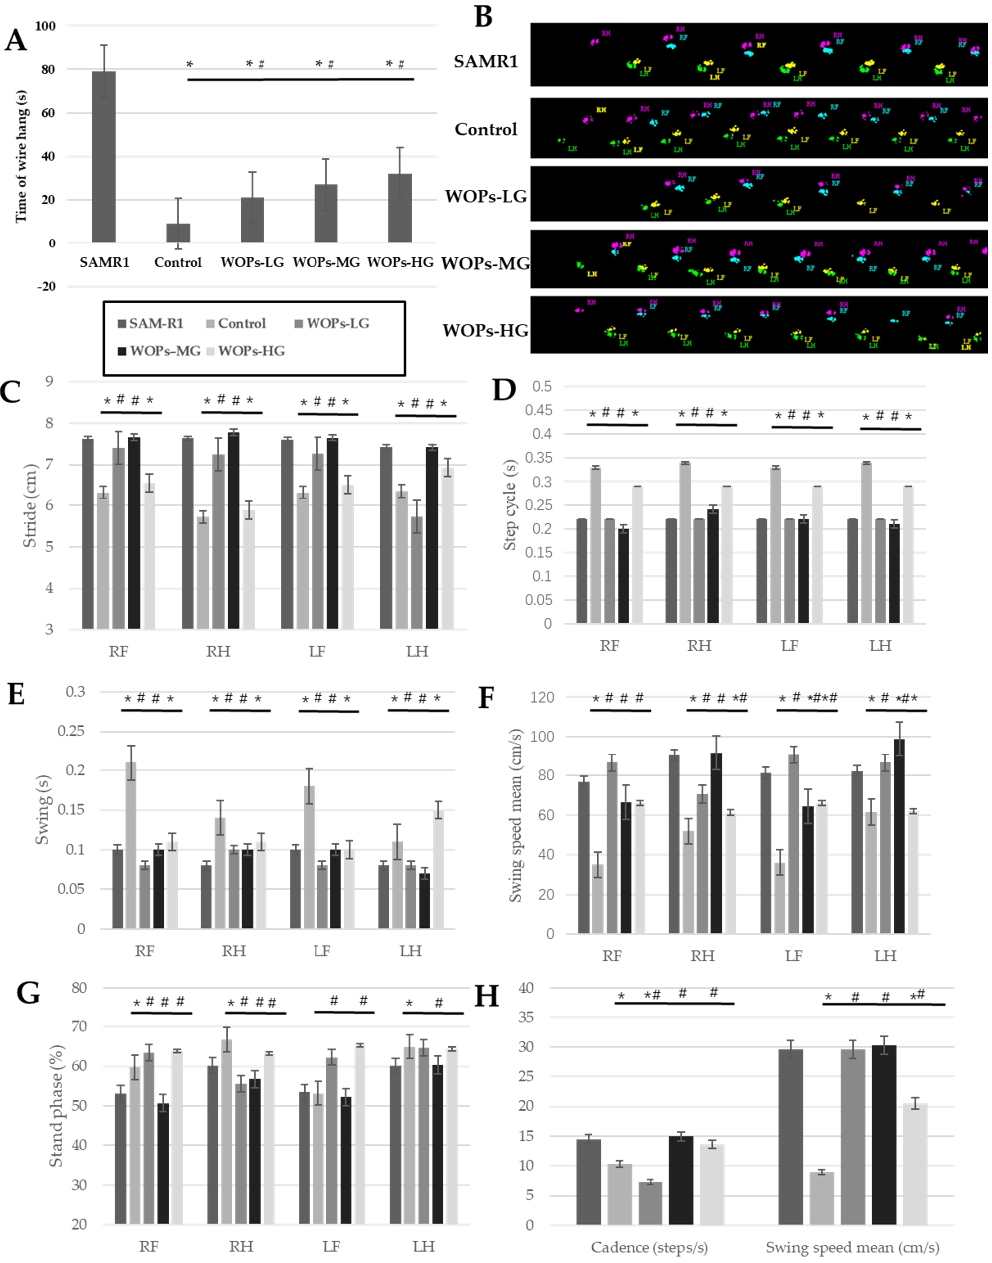
Figure 1. Effects of WOPs on the physical performance. ( A ) Wire hang test; ( B – H ) catwalk test. Data are expressed as mean ± SD ( n = 8 per group). * p < 0.05 vs. SAMR1 and # p < 0.05 vs. Control. SAMR1, SAMR1 model control group; Control, SAMP8 age control group; WOPs-LG, SAMP8-WOPs-LG at a dose of 110 mg/kg · bw; WOPs-MG, SAMP8-WOPs-MG at a dose of 220 mg/kg · bw; WOPs-HG, SAMP8-WOPs-HG at a dose of 440 mg/kg ·